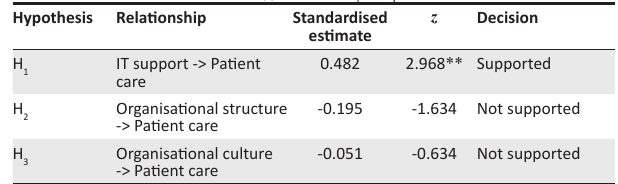
TABLE 6 : Validation of research hypotheses H